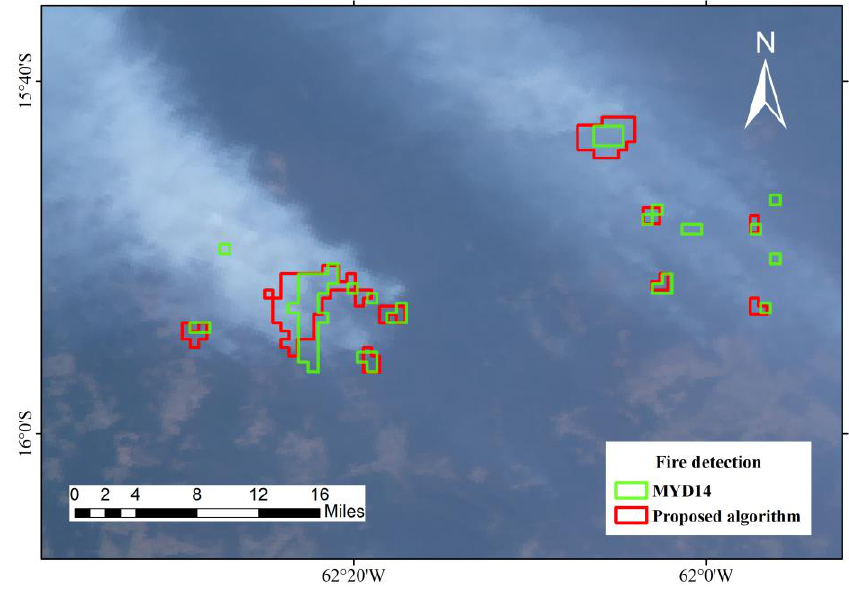
Figure 6. Comparison with MYD14 of 23 August 2019 fire results in the Amazon.